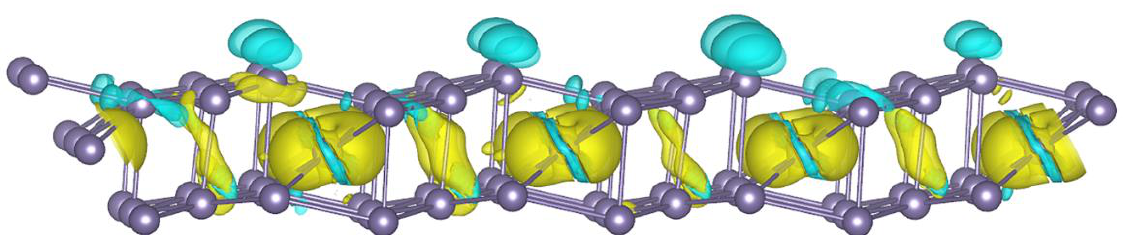
arrows. Figure 2. The localization of hole states (one hole) in the germanium with quantum state |1 ˃ , with a spin down direction s = −1, is the most energetically advantageous state by 0.72 μeV compared with the state |0 ˃ , with a spin up s = +1. The directions of the downward spins s = − 1 are indicated by red arrows.